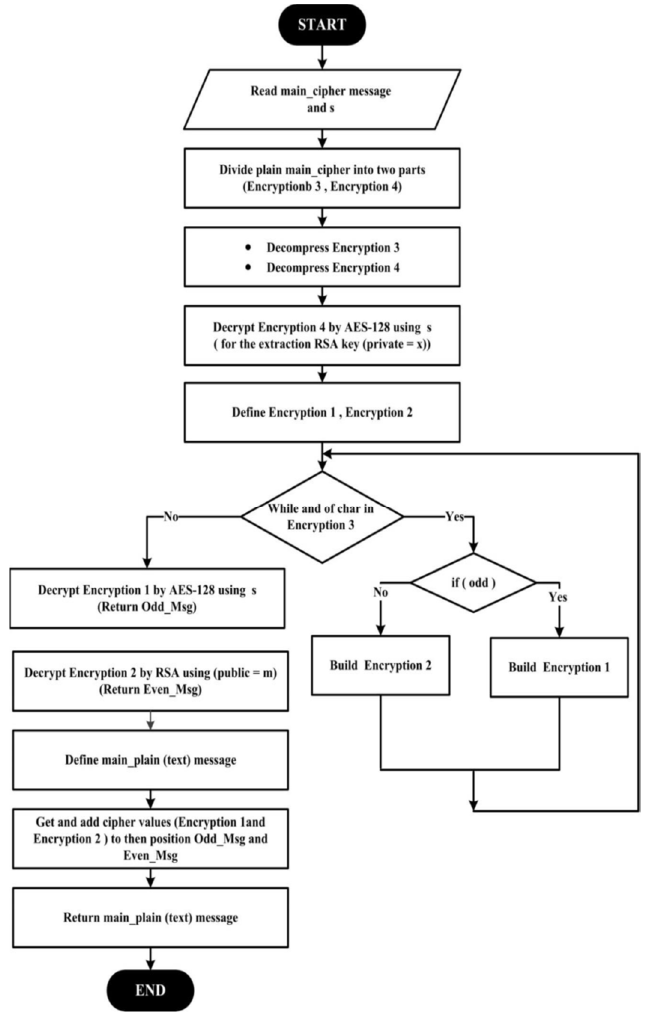
Figure 7. A flowchart of the hybrid (AES and RSA) algorithm decryption.